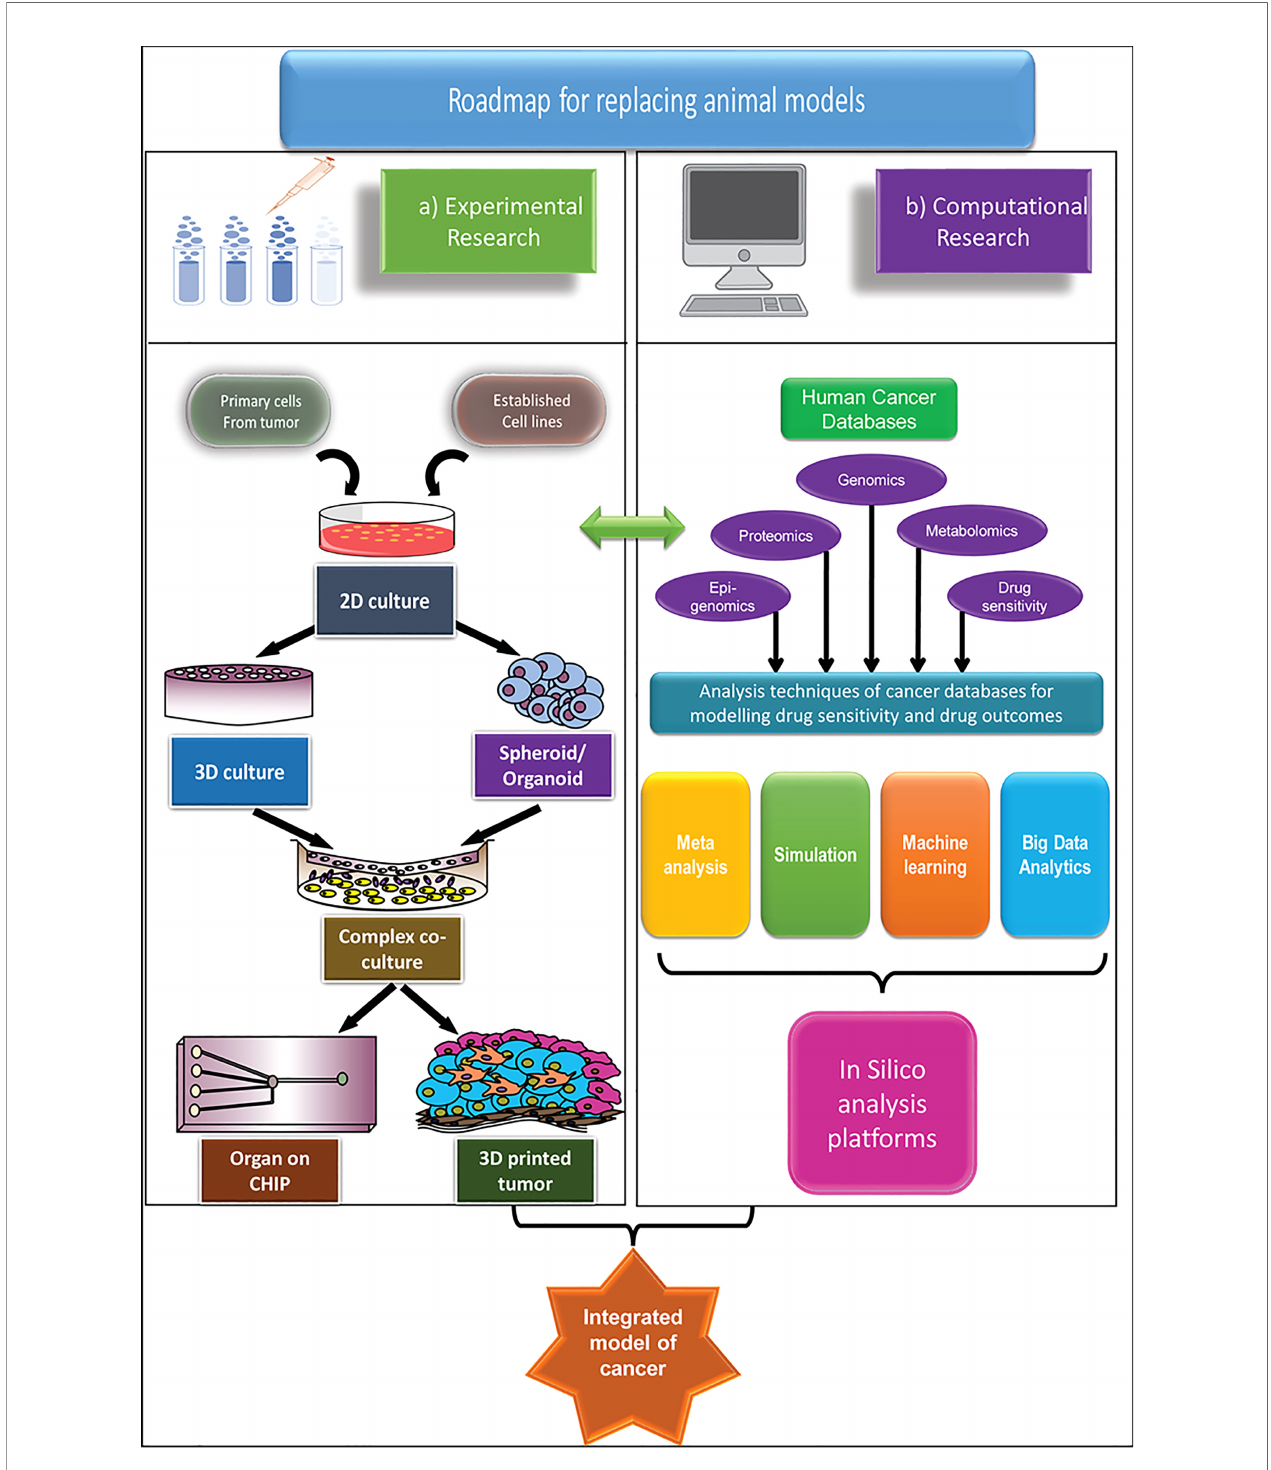
FIGURE 1 | An integrated roadmap to apply advanced human-centric research approaches and potentially replace animal models in cancer research, both for basic and applied research. Two main approaches are considered for replacement of animal models (A) Experimental model and (B) Computational model. The experimental models are mainly based on the in vitro cell culture platforms, which grows in complexity from simple 2D models to the extremely sophisticated organ- on-chip, or 3D printed tumour models to match the speci fi c microenvironment of primary cancer. The computational models take advantage of the different human- based databases and apply different computational methods to model cancer and its outcome. While both methods are advancing signi fi cantly, only by combining the two models, we can hope to truly predict the outcome of the cancer